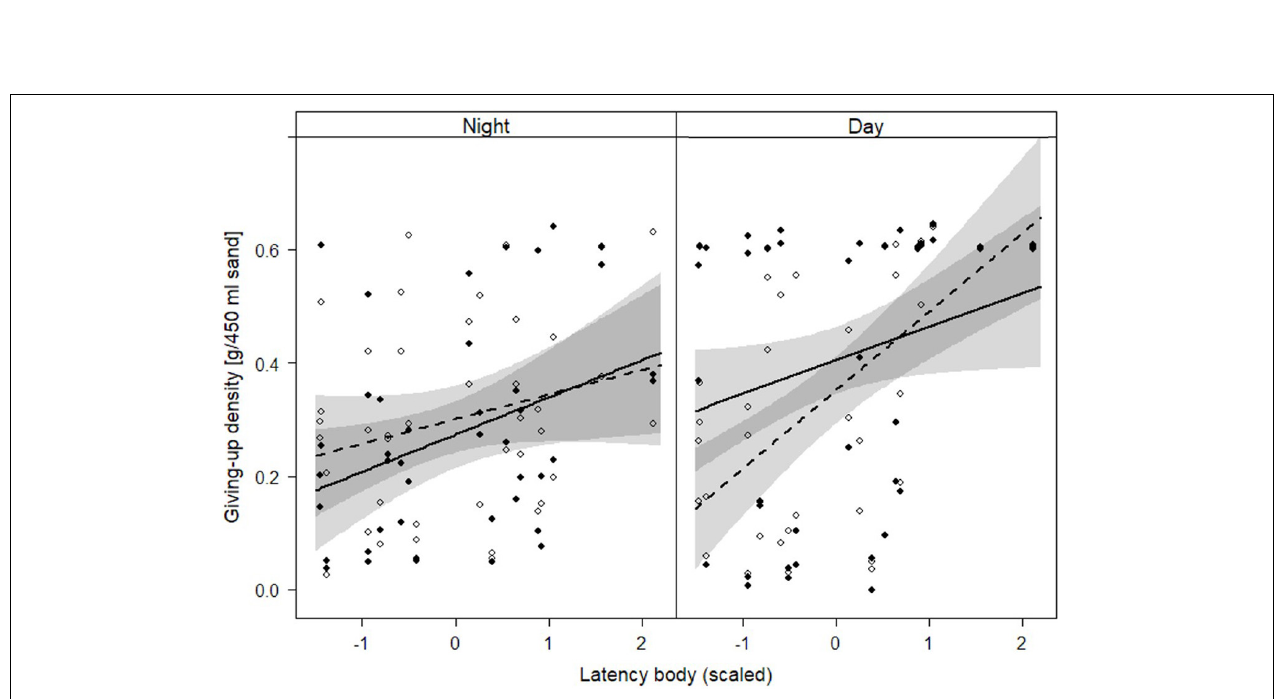
FIGURE 5 | Influence of light treatment, daytime and latency body (scaled) on giving-up density of seed trays. Both sides of the experimental arena contained two seed trays filled with millet and sand. Black dots and the solid line show raw data from the dark side of the arena and the prediction line from the linear mixed effects model, respectively. White dots and the dashed show raw data from the illuminated side of the arena and the prediction line from the model. Gray areas represent 95%-confidence intervals. The higher the latency body, the shyer is the animal.